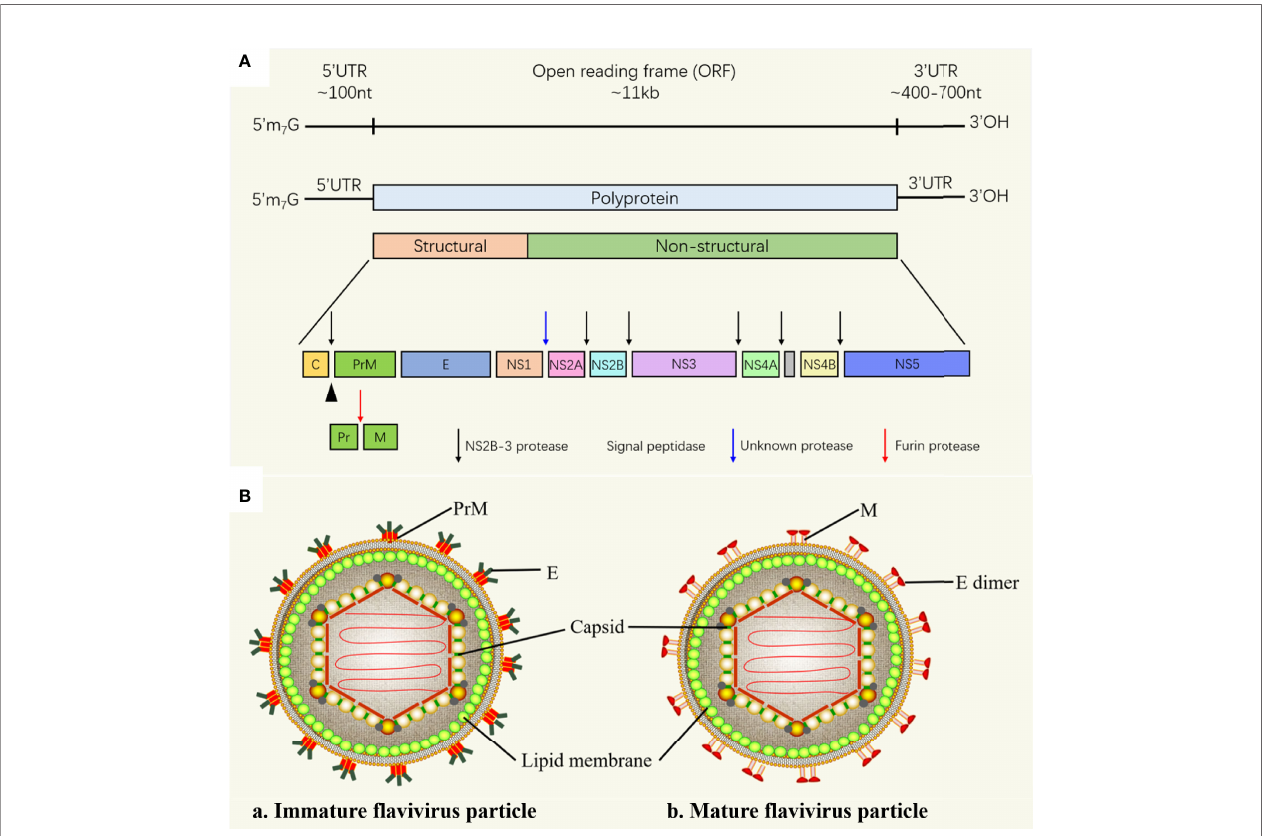
FIGURE 1 | Flavivirus RNA genome and fl avivirus particle. (A) Schematic representation of fl avivirus genome. The polyprotein encoded by the genome is cleaved by the host and virus proteases to form 3 structural proteins: capsid (C), membrane (M) and envelope (E), and 7 nonstructural proteins (NS-1, 2A, 2B, 3, 4A, 4B and 5) (16). (B) Schematic diagram of the fl avivirus particle model. (a) Immature fl avivirus particles. The surface of immature virus particles is covered with 60 trimeric spikes, each of which is composed of a prM-E heterodimer (17). (b) Mature fl avivirus particles. prM of is cleaved into M to form mature particles, there are 90 E homodimers and 90 M homodimers on the surface of each particle